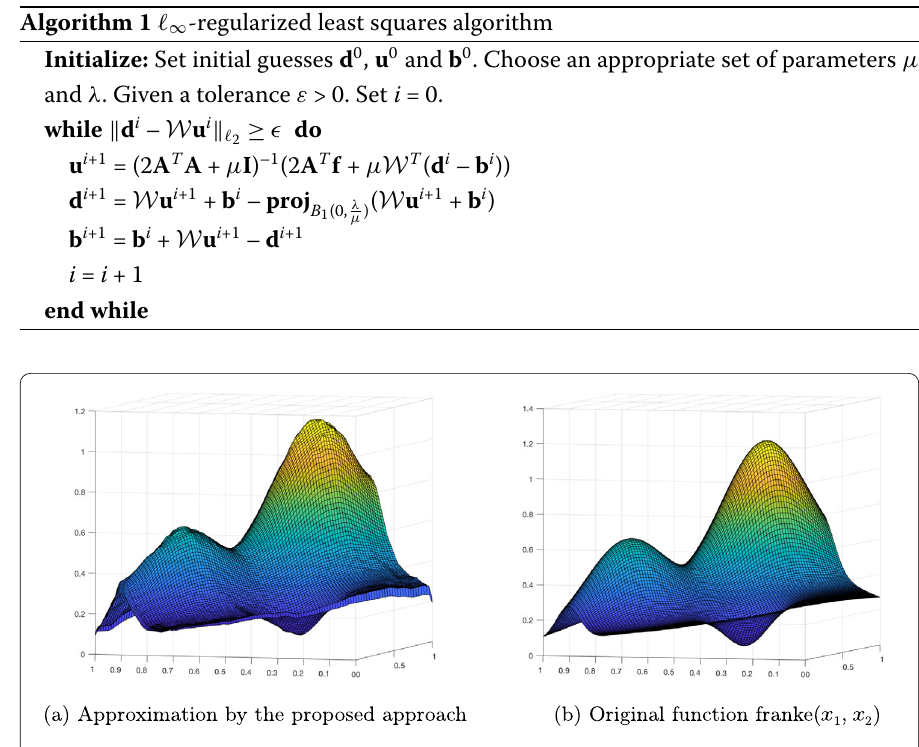
Figure 1 Approximation of 1000 samples from the Franke